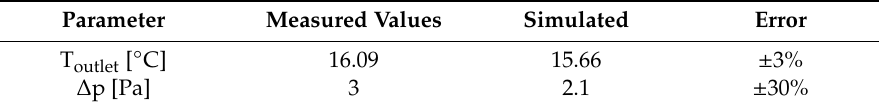
Table 7. Parameters for